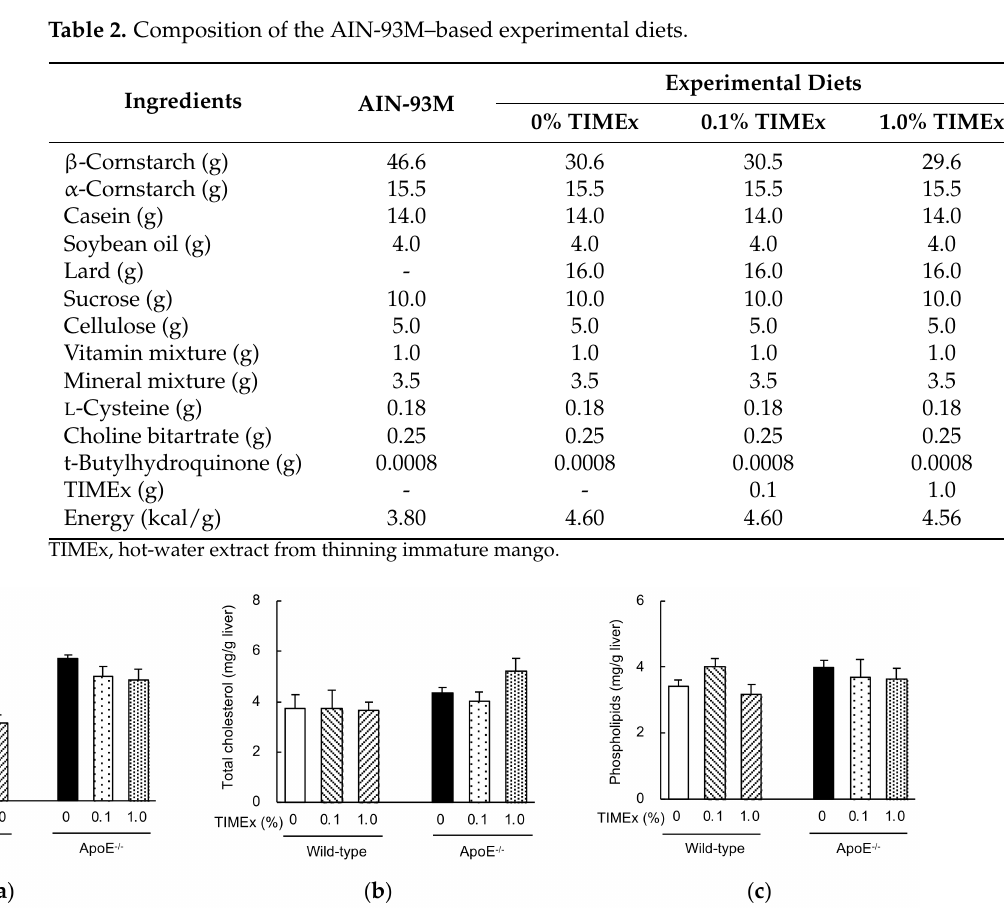
Figure 2. Effects of the consumption of a hot-water extract of thinned immature mangoes (TIMEx) on the hepatic lipid concentrations of apolipoprotein E-deficient (ApoE − / − ) mice. ApoE − / − mice and wild-type BALB/c mice were divided into three diet groups: an AIN-93M-based 20% fat diet containing 0%, 0.1%, or 1.0% TIMEx. A detailed description of the composition of each diet is shown in Table 2. Following 8-weeks consumption of their respective diets, mice were sacrificed without fasting. The data are mean ± SEM; n = 6 for wild-type mice and n = 9 for ApoE − / − mice. ( a ) Triglyceride, ( b ) total cholesterol, and ( c ) phospholipid concentrations. There were no significant differences versus the control group (0%